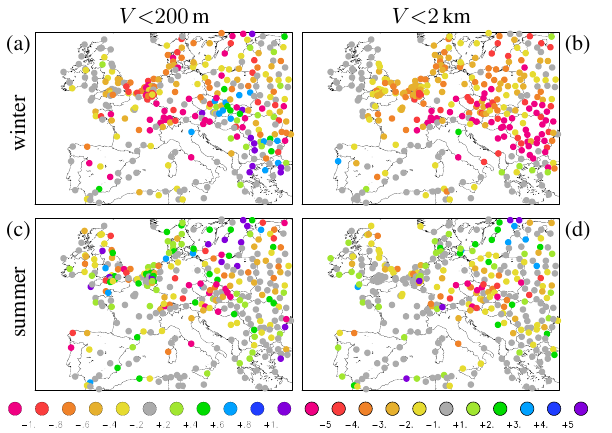
Fig. 12. The regression of the number of dense fog (a) and (c) , and mist (b) and (d) days on zonal geostrophic wind A U [dym − 1 s], in winter (a) and (b), and summer (c) and (d).